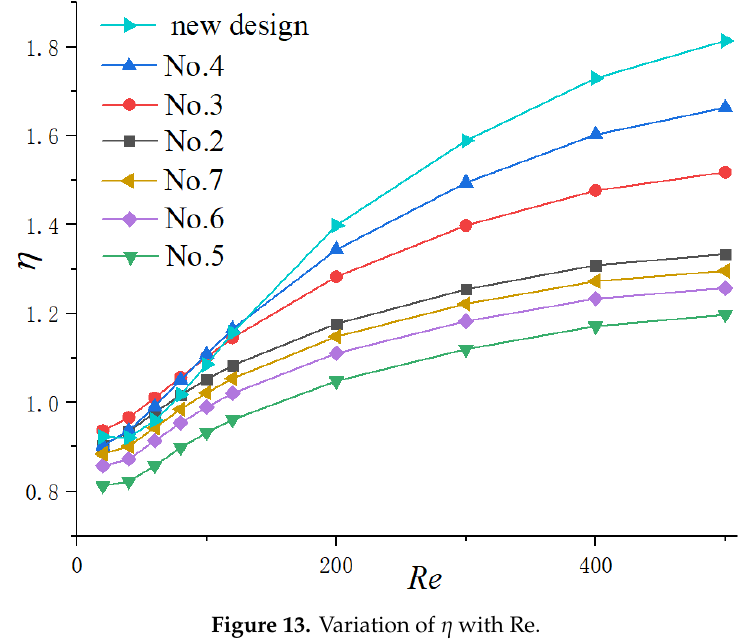
Figure 12. New shape of cavities proposed in this paper.